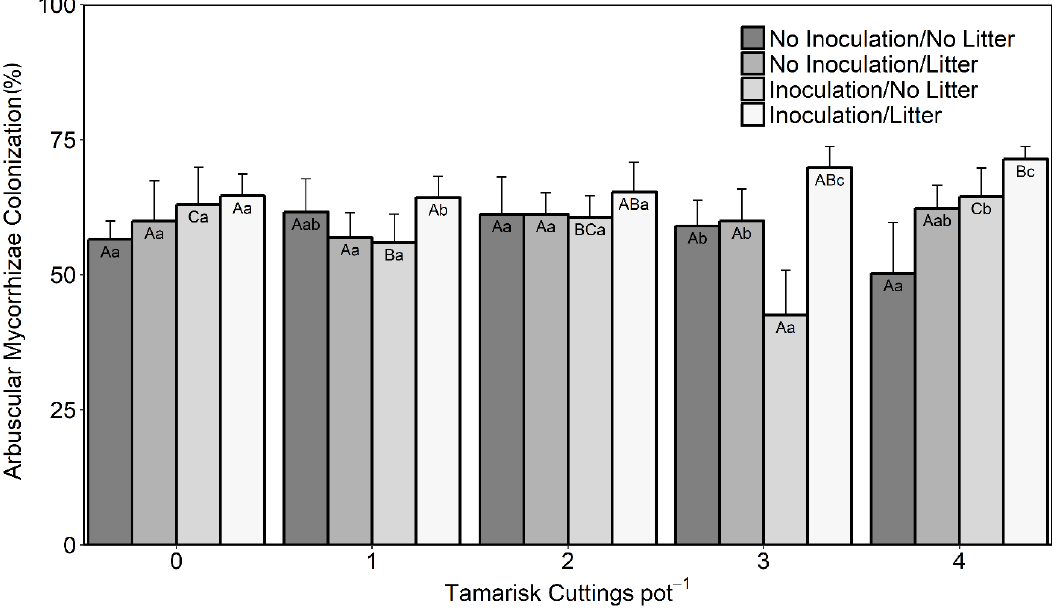
Figure 3. The influence of tamarisk stem density, soil inoculation and tamarisk litter on arbuscular mycorrhizae colonization of mule-fat roots. Data are means with n = 5. Error bars indicate +SE. Di ff erences within tamarisk stem density and within soil treatment were analyzed separately by ANOVA followed by lsmeans post hoc tests incorporating run and block as random e ff ects. Di ff erent uppercase letters indicate di ff erences within an inoculation-litter treatment across stem densities ( p -value < 0.05). Di ff erent lowercase letters indicate di ff erences between inoculation-litter treatments within a stem density ( p -value < 0.05).